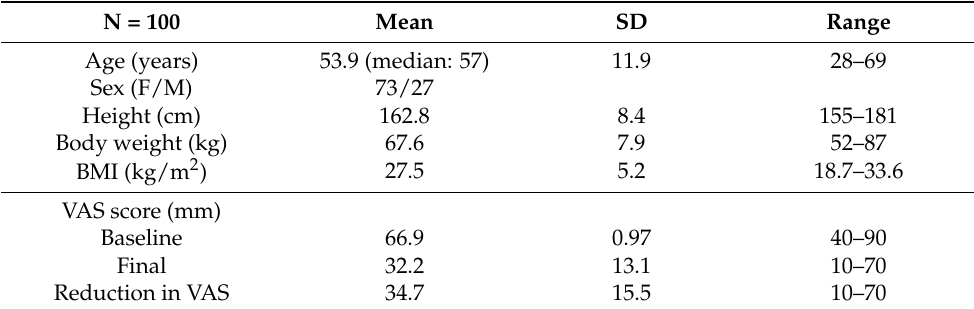
Table 1. Demographics of the patients with